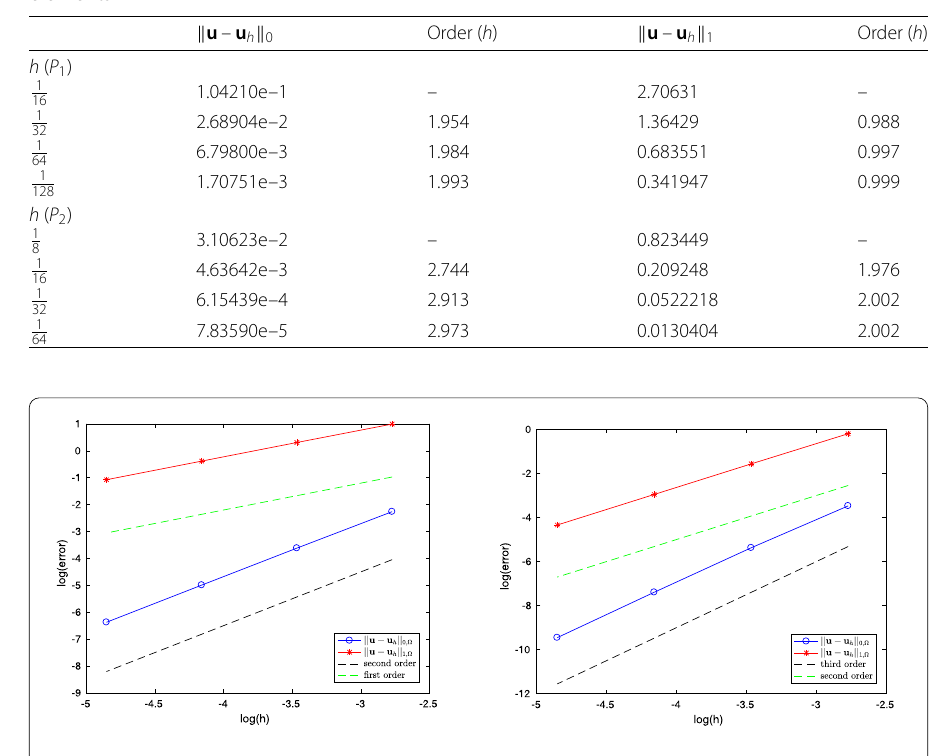
Table 1 Convergence order with respect to h of the stabilized method for Example 1 with P 1 and P 2 elements